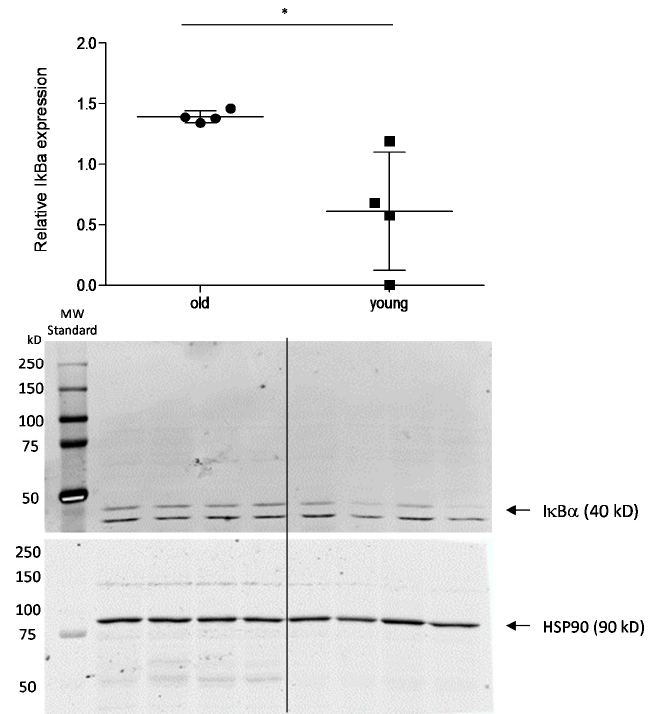
Figure 5. Effect of age on expression of I κ B α in mice with nociceptive stimulation. Western blot analysis of I κ B α expression in the spinal cord of young and old mice 45 min after injection of formalin into the hind paw. The diagram shows the densitometric analysis of three independent experiments, the blots one representative example, ( n = 4). Due to scanning the blots at two different wavelengths, the standard is only visible in the I κ B α blot. * p < 0.05, statistically significant difference between the groups.